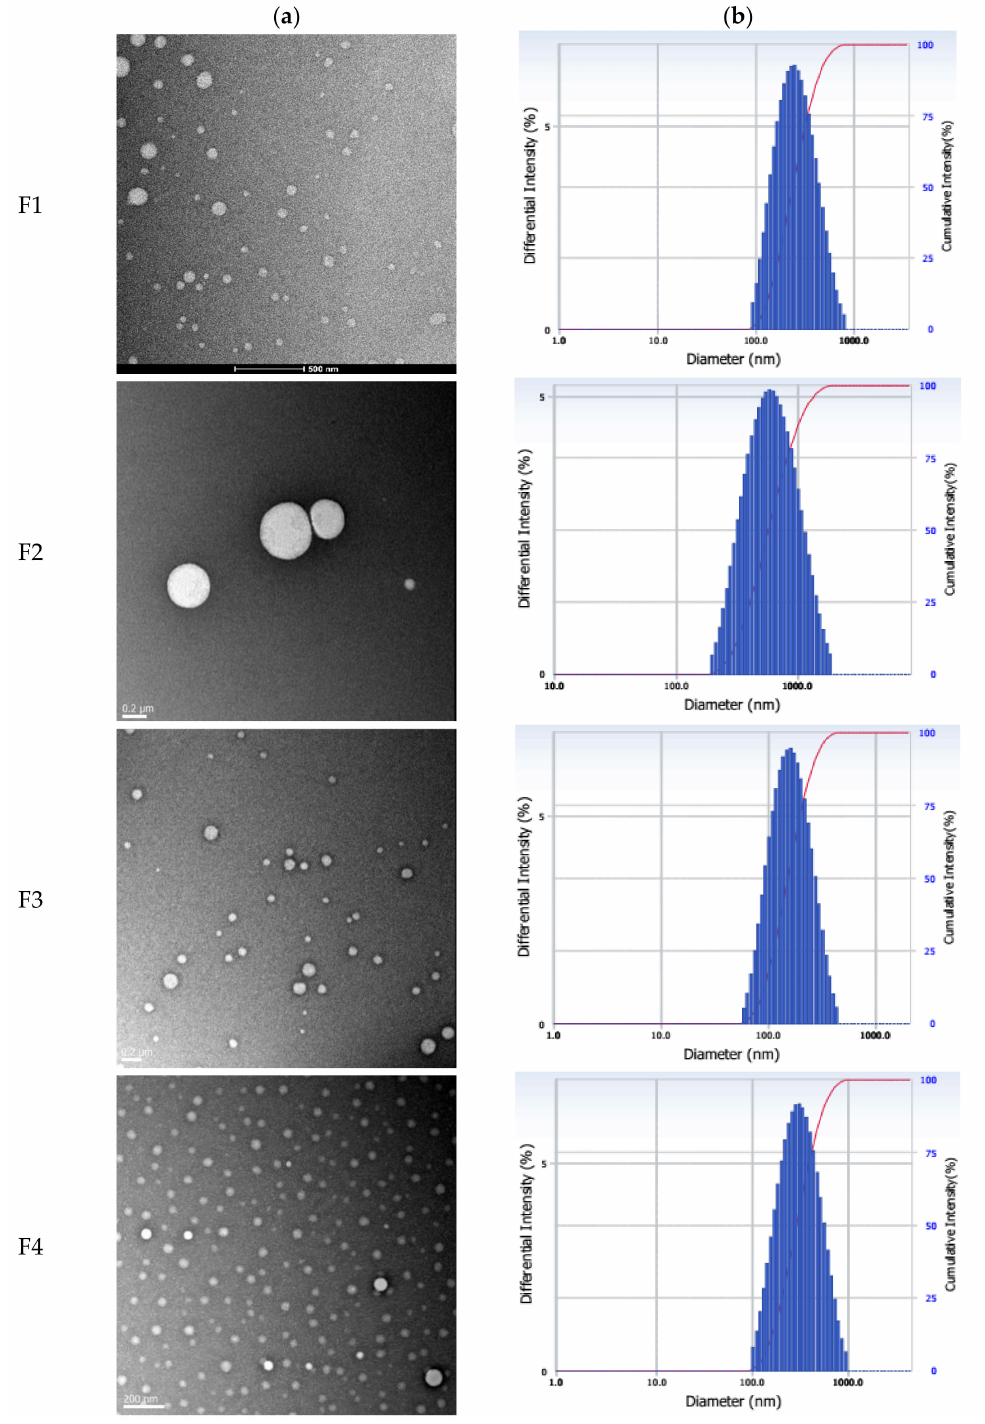
Figure 2. ( a ) Morphological shapes of the orobol-loaded formulations (F1 to F4) observed by transmission electron microscopy (TEM) and ( b ) their particle size distribution. The scale bars represent 0.2 µ